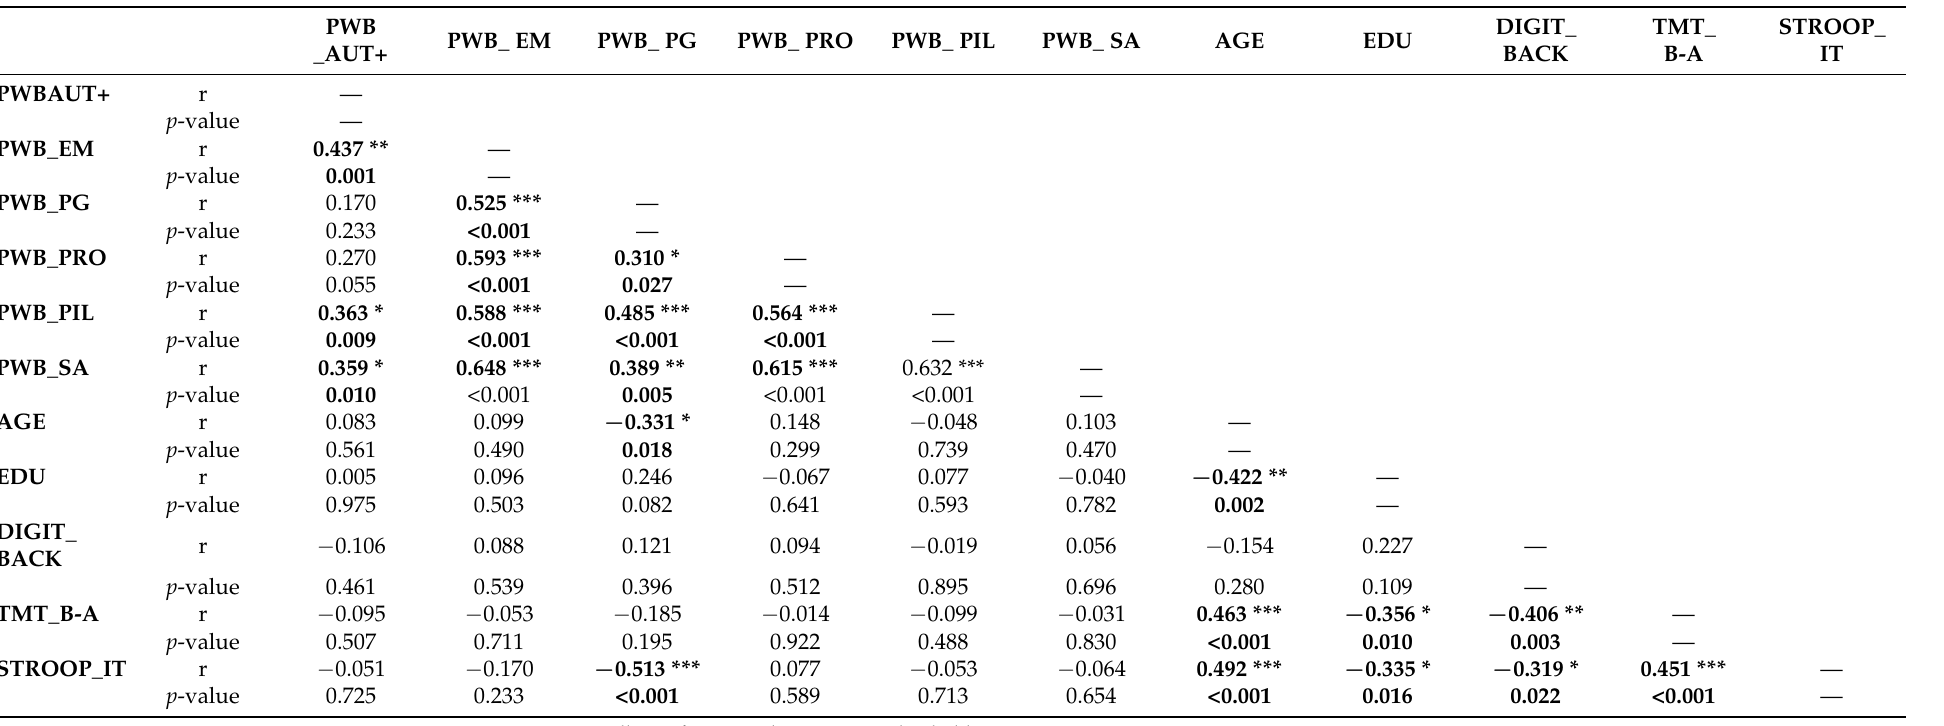
Table 3. Two-tailed correlations between psychological well-being (PWB), age and the core executive functions. AUT = Autonomy; EM = Environmental Mastery, PG = Personal Growth; PRO = Positive Relations with Others; PIL = Purpose in Life, and SA = Self-Acceptance; EDU = educational level. + = square root